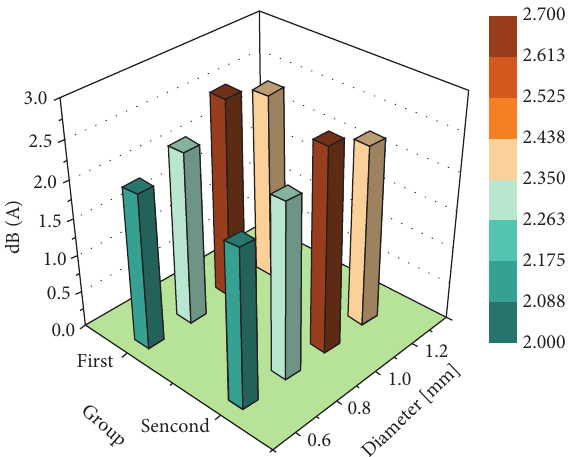
Figure 10: The value of noise suppression aerated different quality refrigerant.